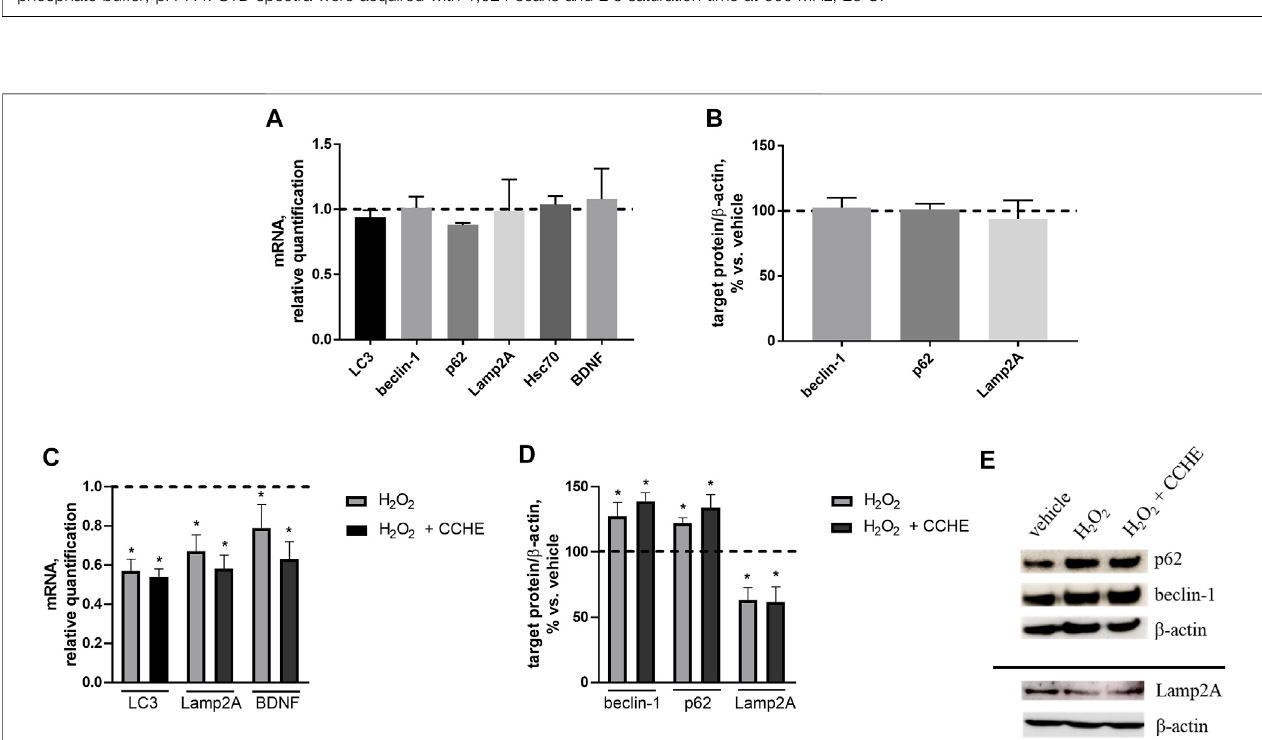
FIGURE 8 | (A,B) . Effect of cinnamon extract CCHE (10 µg/ml, 24 h) on autophagy markers in human SH-SY5Y cells under standard culture conditions. (A) Relative mRNA levels of macroautophagy (LC3, beclin-1, and p62) and CMA (Lamp2A and Hsc70) markers and BDNF. (B) Protein expression of macroautophagy (beclin-1andp62)andCMA(Lamp2A)markers. (C – E) .EffectofcinnamonextractCCHEonautophagymarkersinhumanSH-SY5Ycellsexposedtohydrogenperoxide (H 2 O 2 ). Cells were pretreated with CCHE (10 µg/ml) for 1 h and then cotreated with H 2 O 2 (50 μ M, 24 h. (C) Relative mRNA levels of macroautophagy (LC3) and CMA (Lamp2A) markers and BDNF. (D) Protein expression of macroautophagy (beclin-1 and p62) and CMA (Lamp2A) markers and (E) representative Western blot image showing immunoreactivity for the target proteins and the corresponding β -actin, used as internal standard. N = 3, p < 0.05 vs. vehicle-treated cells.